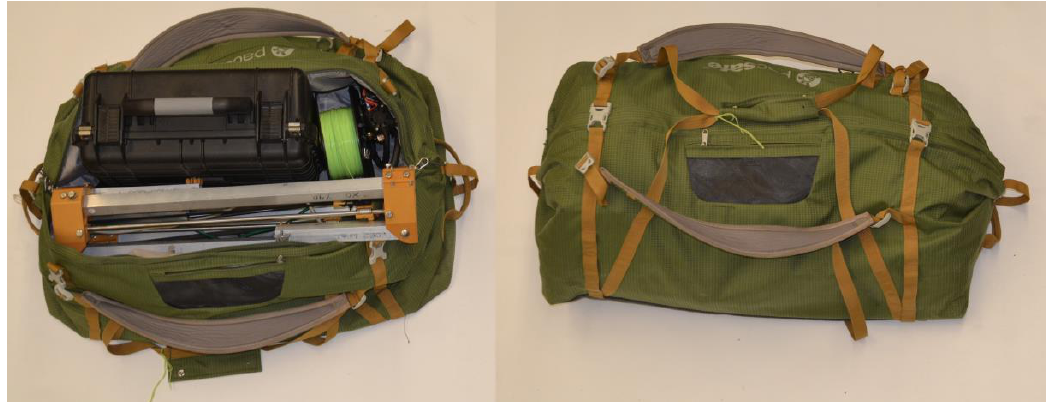
Figure 5. The Kijenzi 3-D printer can be disassembled and fit into a backpack or travel duffle.